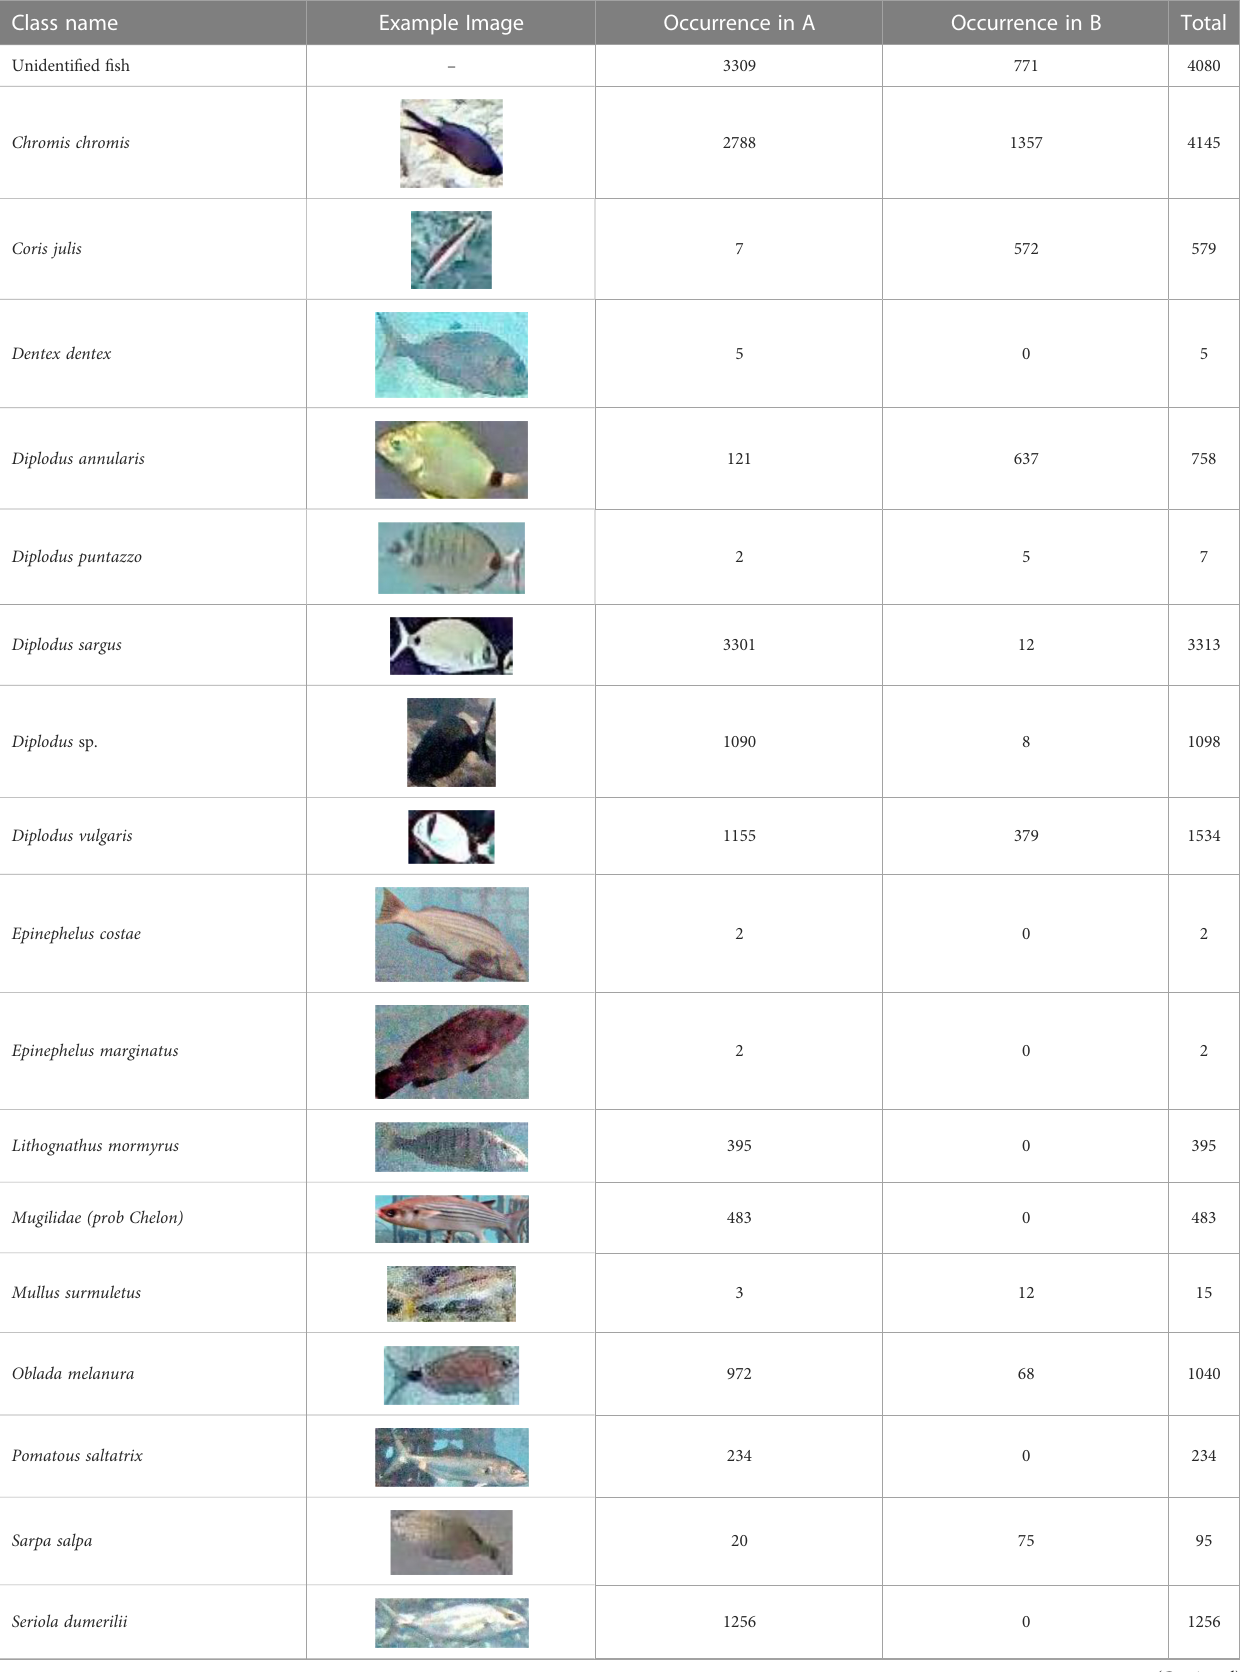
TABLE 2 Count and image example (after MSR model pre-processing) of the main fi sh classes appearing in datasets A and